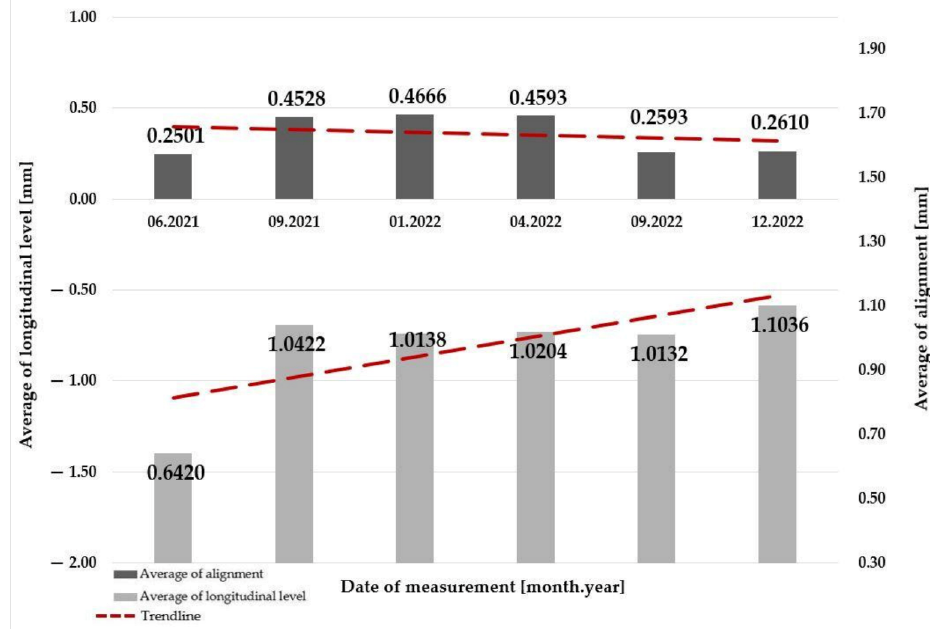
Figure 15. The change of average values of longitudinal level and alignment in Section